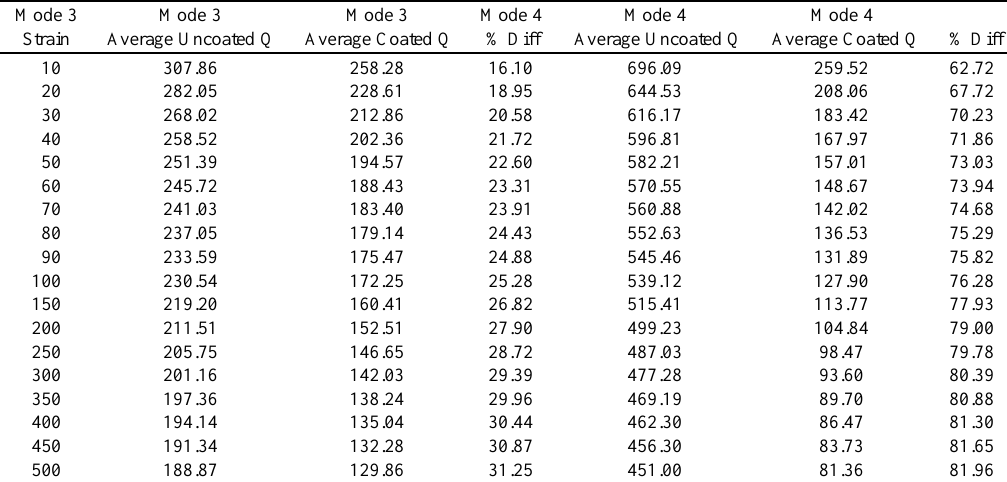
Table 6 Average uncoated versus average coated Q comparison at different